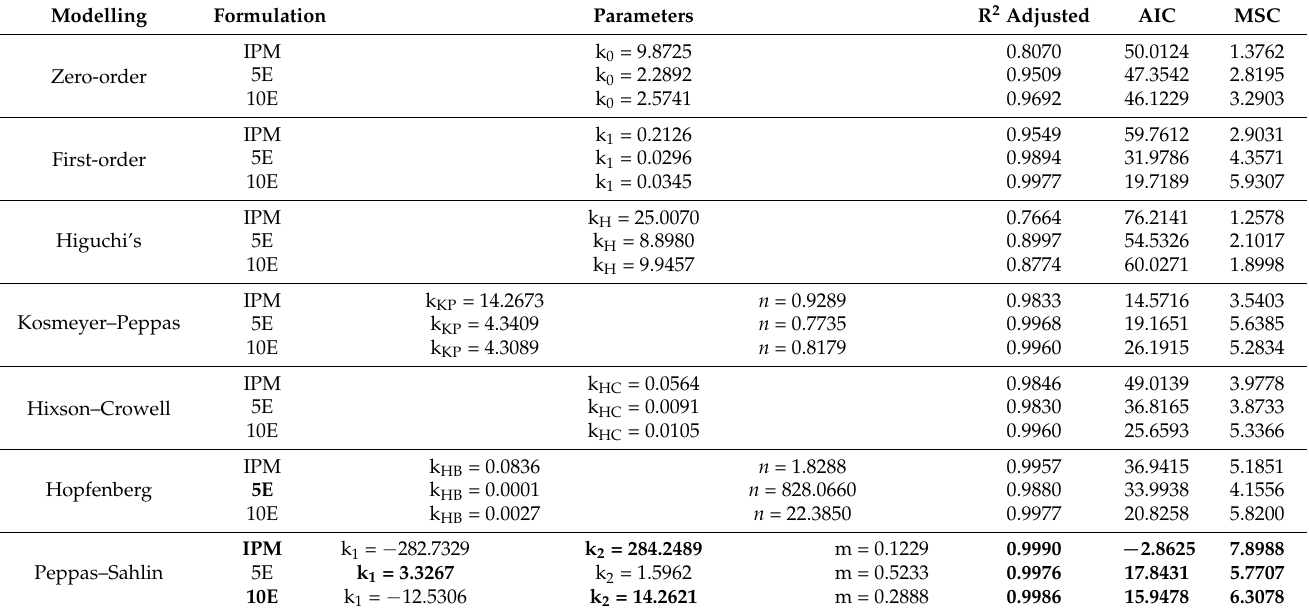
Table 4. Mathematical modelling of IBU release from effervescent matrix tablets in pH 6.8 phosphate